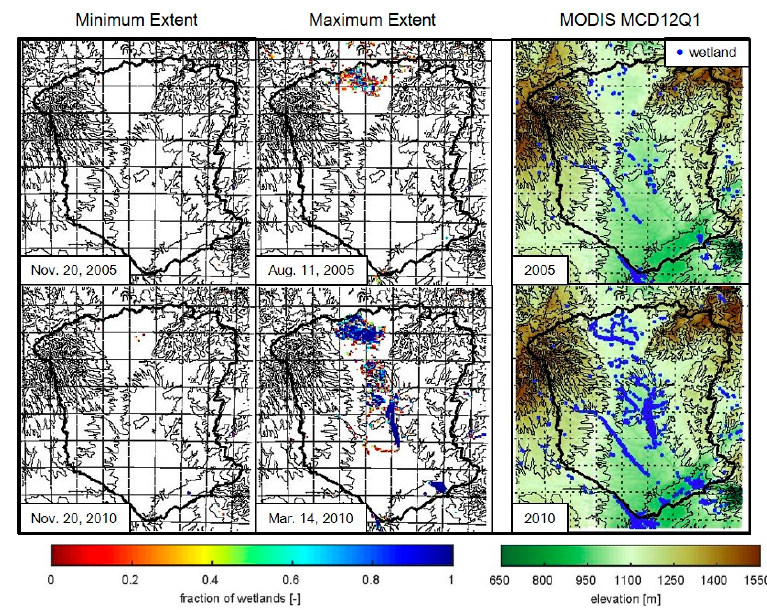
Figure 6. Maps of wetland fractions for the days of minimum and maximum wetland extent displayed alongside the corresponding MODIS MCD12Q1 static wetland land cover class in 2005 and 2010. Topographic contours are displayed as black lines at every 100 m between 650 m and 1550 m.